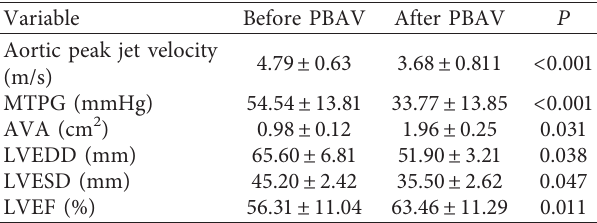
Table 3: Comparison of preprocedural and postprocedural echocardiographic